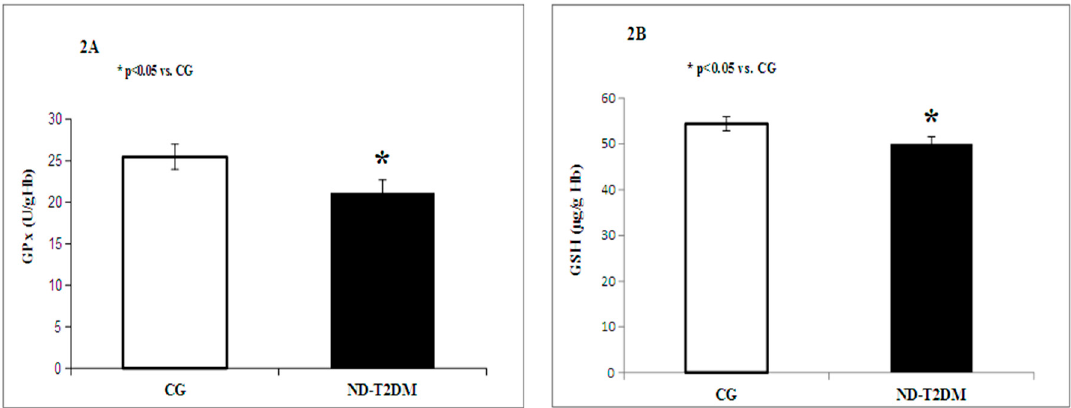
Figure 2. Circulating levels of glutathione peroxidase (GPx) ( A ) and glutathione (GSH) ( B ) in patients with ND-T2DM versus control group (CG). The intensity of respiratory burst (RB) was increased after stimulation with phorbol- 12myristate-13acetate (PMA) and with opsonized zymosan (OZ) of PBMCs isolated from diabetic patients versus healthy subjects ( p < 0.05) (Figure 3A,B).